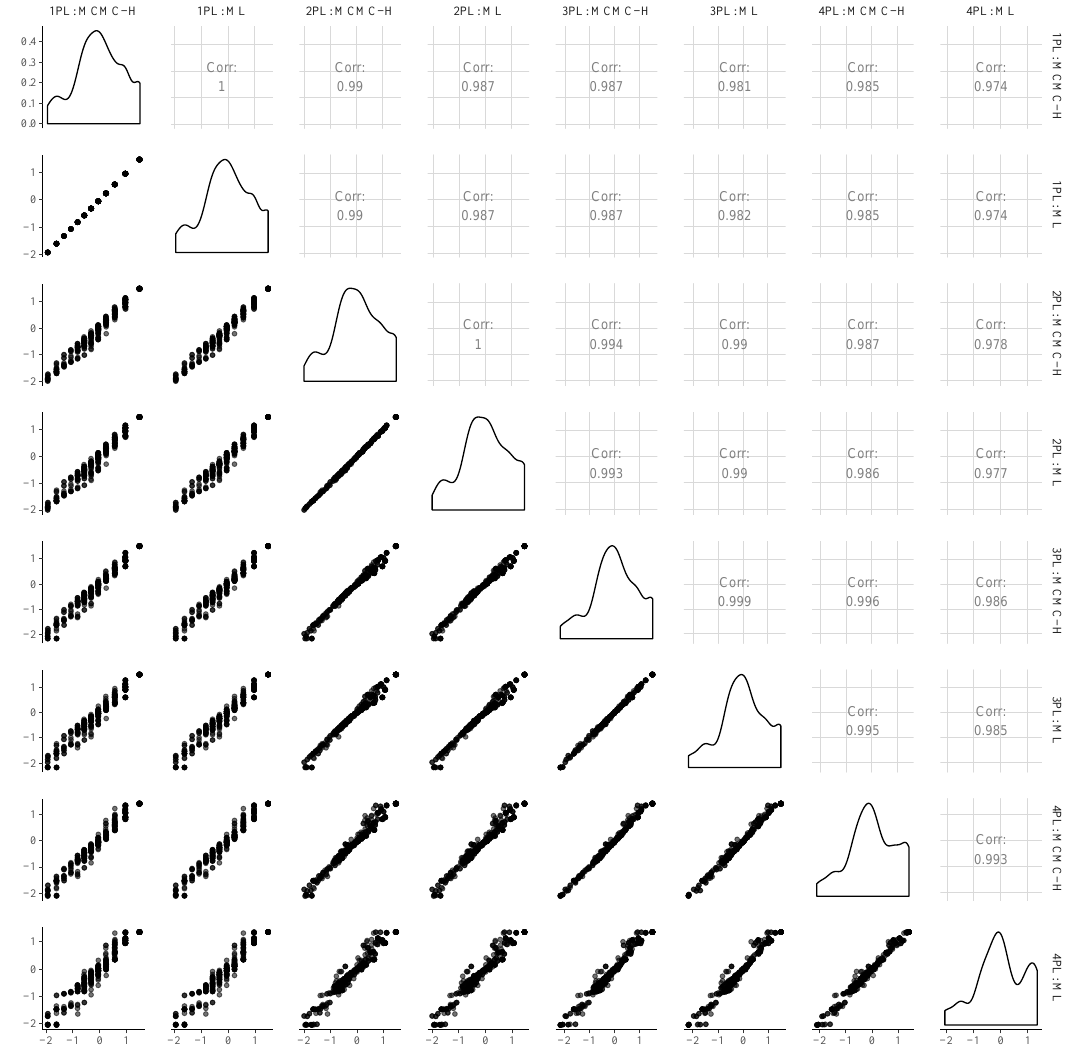
Figure 9. Scatter plots, bivariate correlations, and marginal densities of person parameters from MCMC-NH and ML